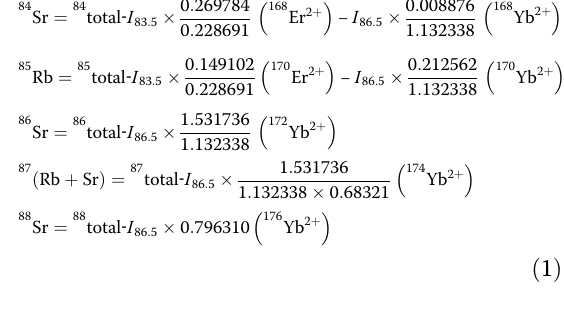
Table 2 Er and Yb isotopic compositions and ratios reported in the literature Amount fraction (Chang et al. 1998)